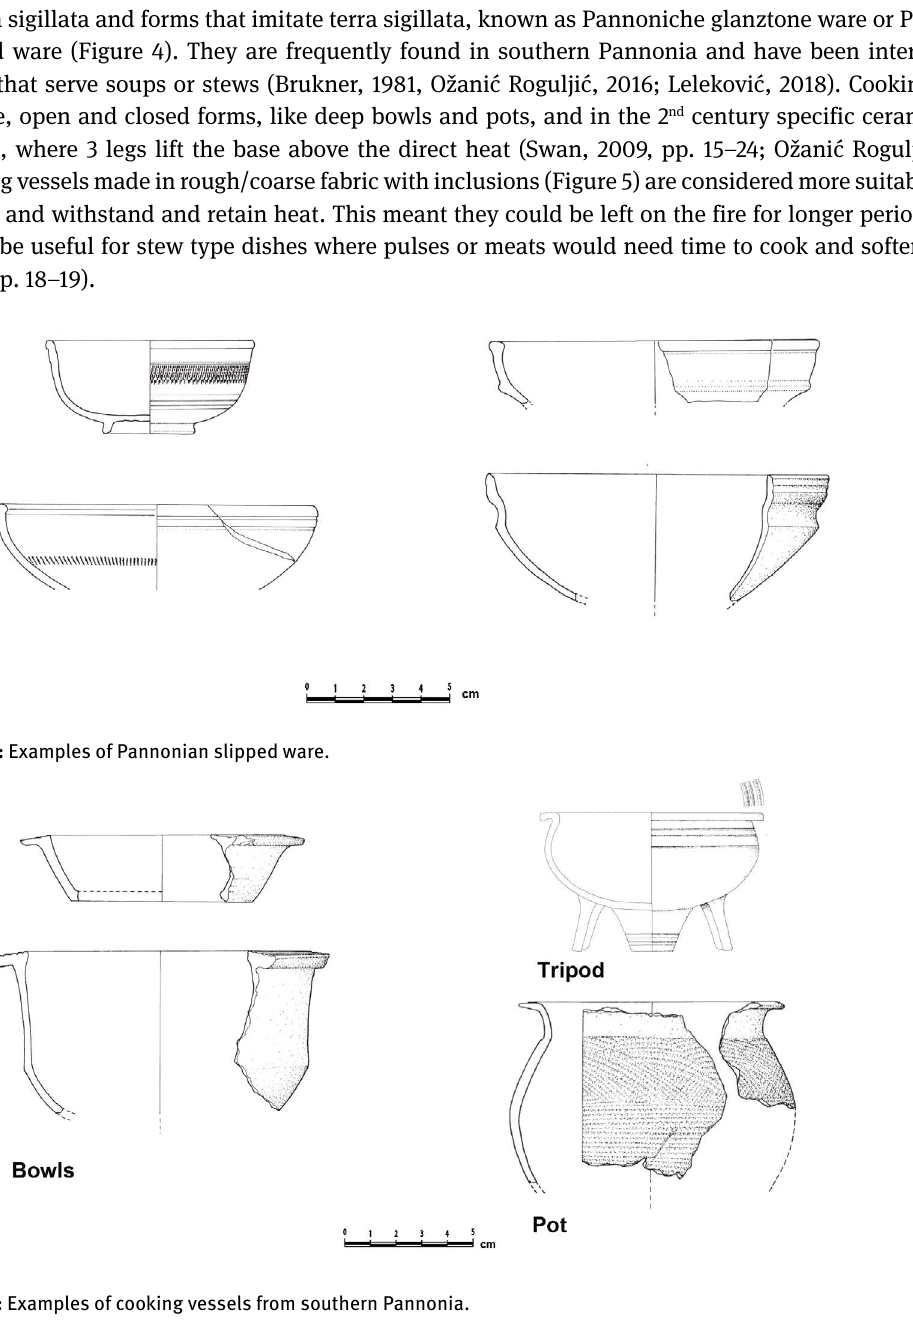
Figure 5: Examples of cooking vessels from southern